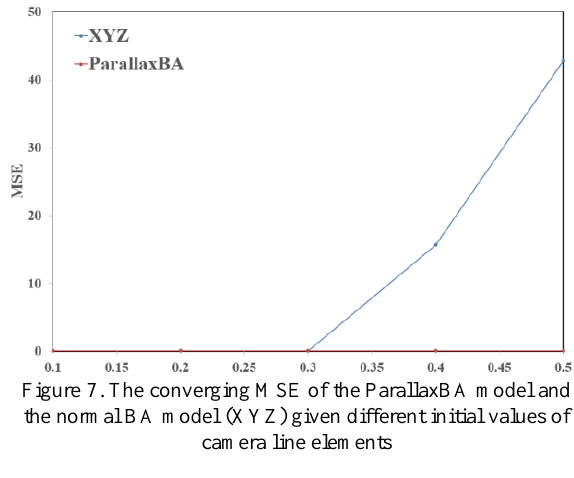
Figure 7. The converging MSE of the ParallaxBA model and the normal BA model (XYZ) given different initial values of camera line